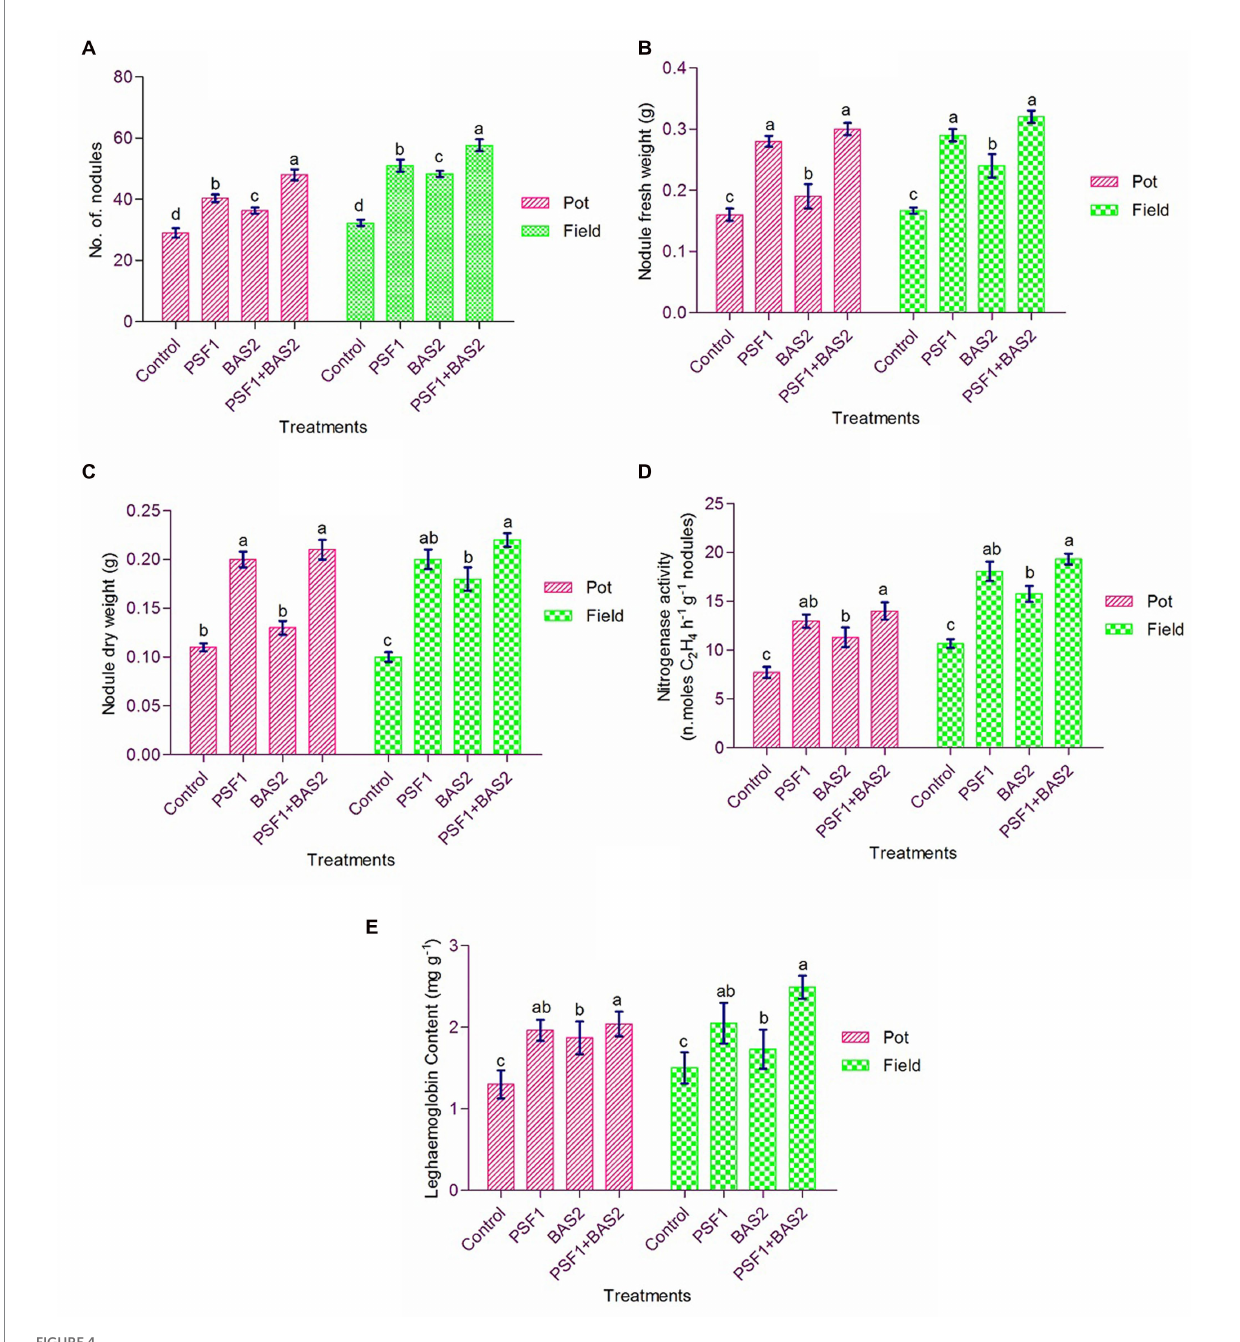
FIGURE 4 Effects of PGPR biostimulants Pseudomonas fluorescens (PSF1) and Bacillus subtilis (BAS2) on nodulation, nitrogenase activity and leghaemoglobin content under pot and field conditions. (A) Number of nodules; (B) nodule fresh weight; (C) nodule dry weight; (D) nitrogenase activity; and (E) leghaemoglobin content. Error bar represents the standard deviation ( n = 3). Small alphabetical letters above the error bar indicate significant difference between treatments according to Tukey’s post-hoc test ( p ≤